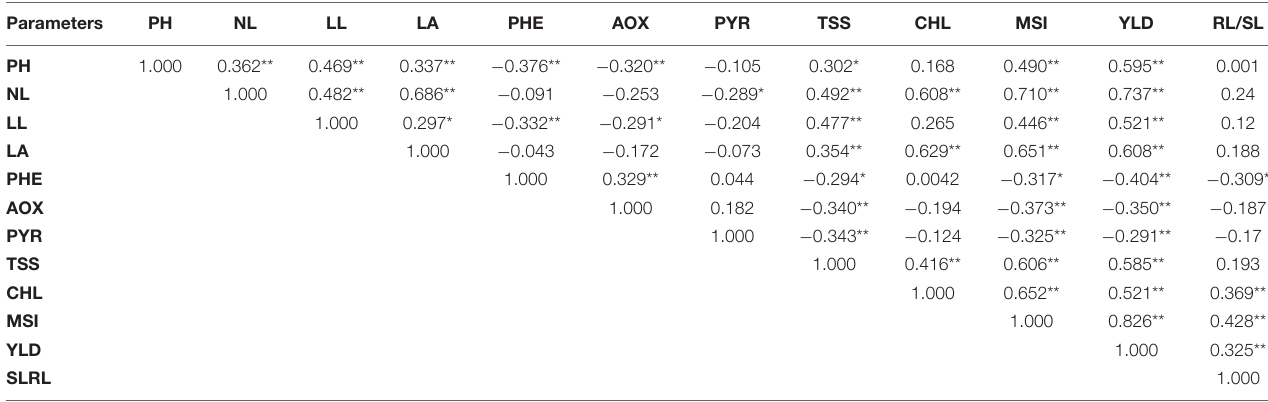
TABLE 8 | Pearson correlation coefficient among the studied traits in contrasting genotypes under control and waterlogging conditions. Parameters PH NL LL LA PHE AOX